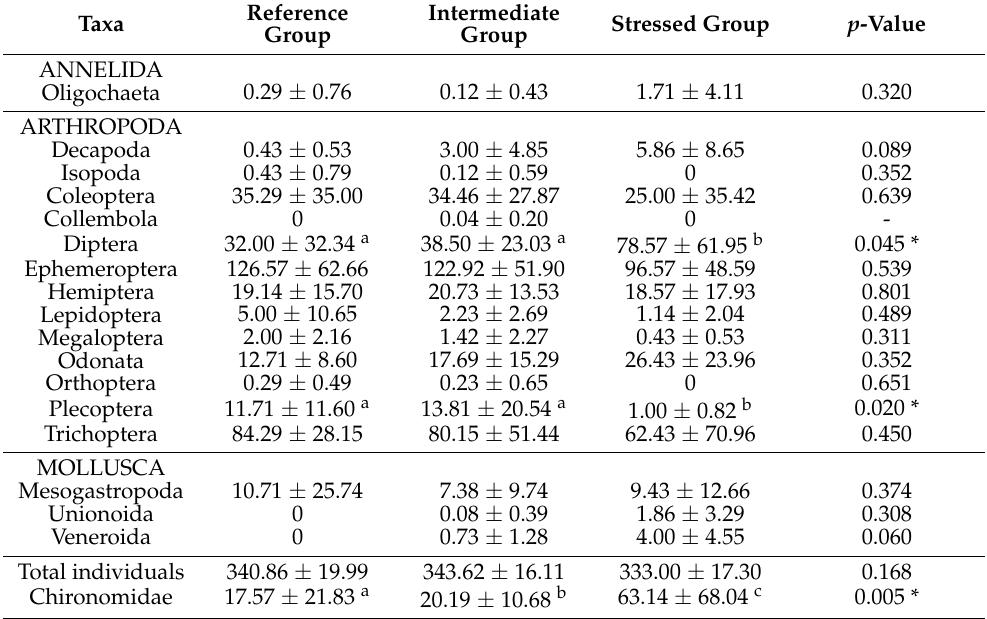
Table 4. Relative abundance of benthic macroinvertebrates found in reference, intermediate, and stressed sites. Data are expressed as Mean ±